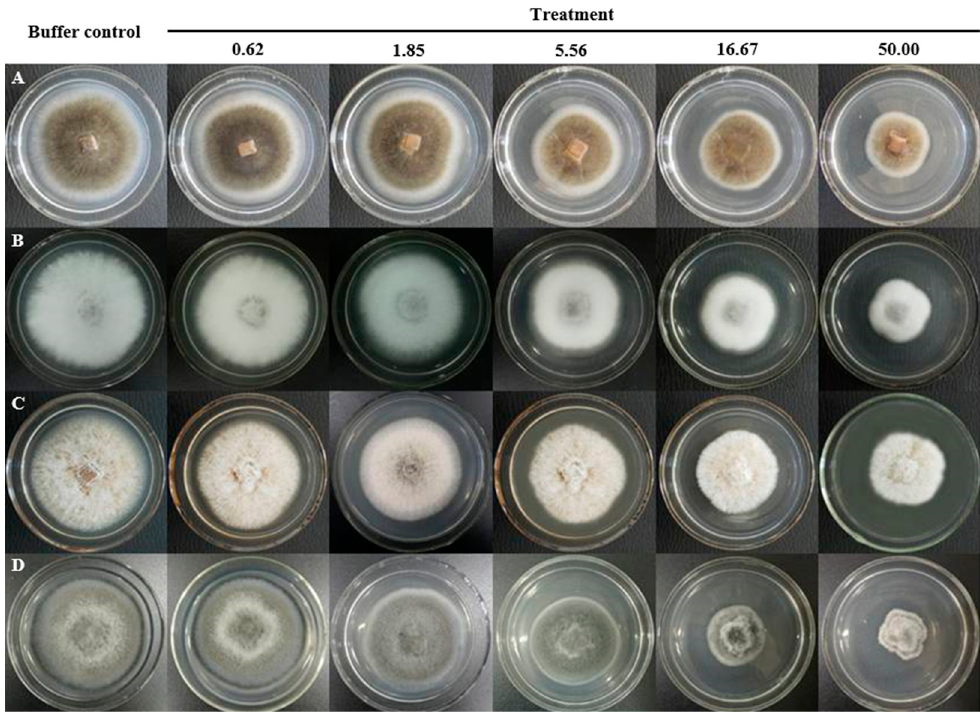
Figure 3. IC 50 determination of BGAP toward four phytopathogenic fungi: ( A ) Colletotrichum higginsianum ; ( B ) Exserohilum turcicum ; ( C ) Magnaporthe oryzae ; and ( D ) Mycosphaerella arachidicola ; numerical value represents the concentration ( μ g/mL) of BGAP in the medium.